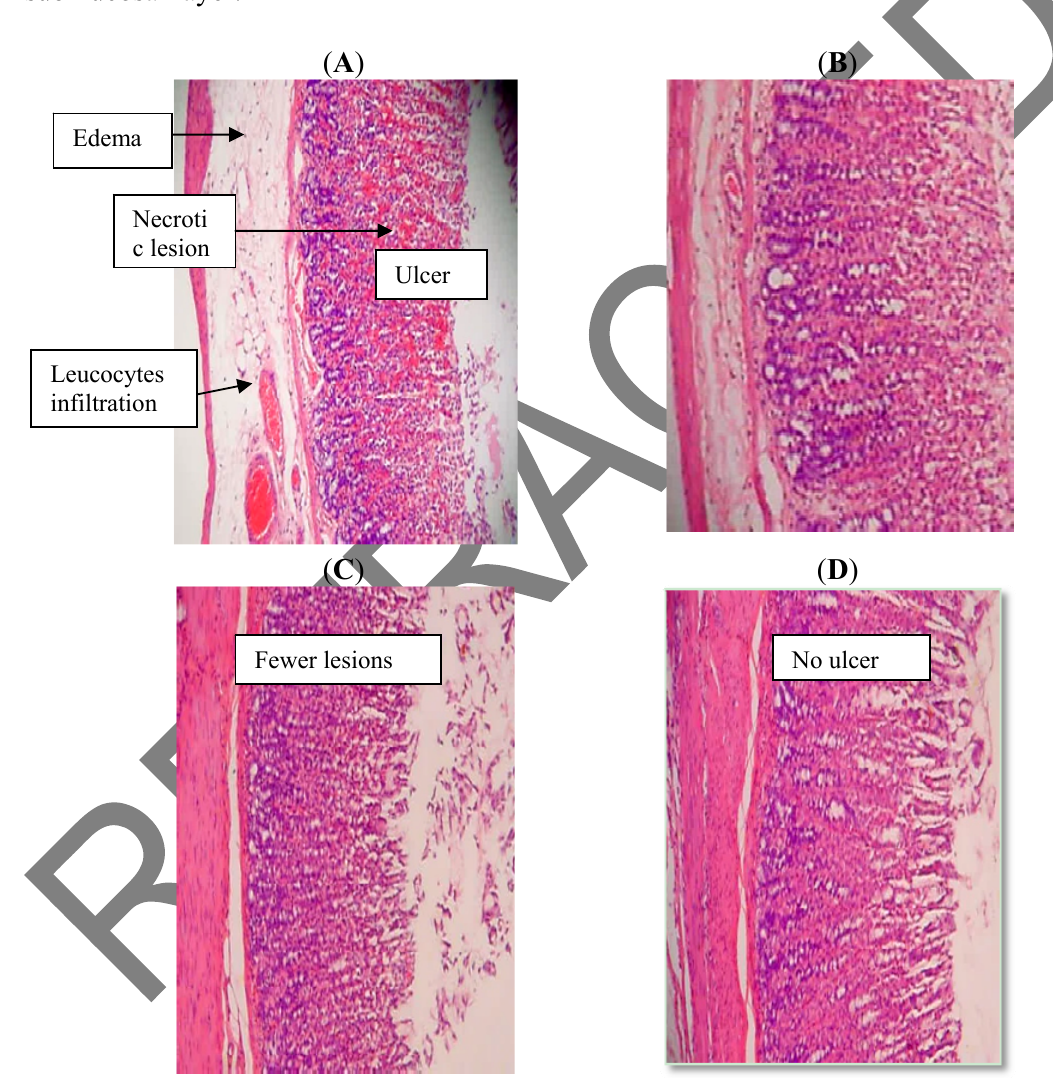
Figure 3. Histological sections of the ethanol-induced gastric mucosal damage in rats (H&E stain 10×). ( A ) Rats pre-treated with 5 mL/Kg of 10% Tween 20 solution (ulcer control). There is severe disruption to the surface epithelium, and edema of the submucosal layer with leucocytes infiltration. ( B ) Rats pre-treated with 20 mg/kg of omeprazole. There is mild disruption to the surface epithelium with no edema and no leucocytes infiltration of the submucosal layer. ( C ) Rats pre-treated with 200 mg/kg of BClHC. There is very mild disruption to the surface epithelium with no edema and no leucocytes infiltration of the submucosal layer. ( D ) Rats pre-treated with 400 mg/kg of BClHC. There is no disruption to the surface epithelium with the absence of edema and leucocytes infiltration of the submucosal layer.